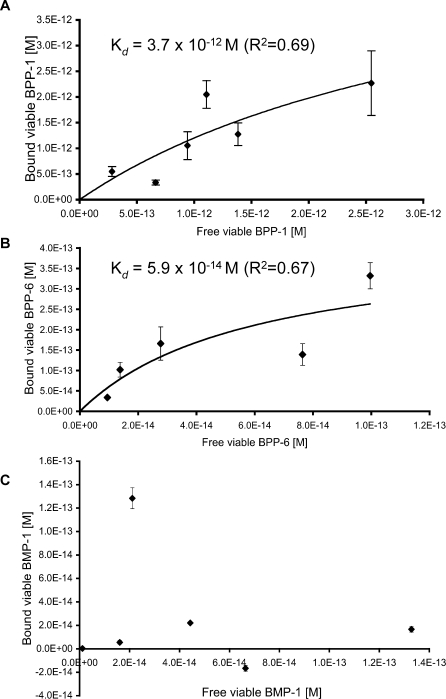
Phage Binding to Bordetella
Binding of (A) BPP-1, (B) BPP-6, and (C) BMP-1 to Bvg+
Bordetella. For BPP-1 and BPP-6, binding to Bvg–
Bordetella was subtracted as nonspecific background, and for BMP-1, binding to E. coli was subtracted as nonspecific background. Phage concentrations were determined by plaquing on appropriate hosts and thus represent viable phage.